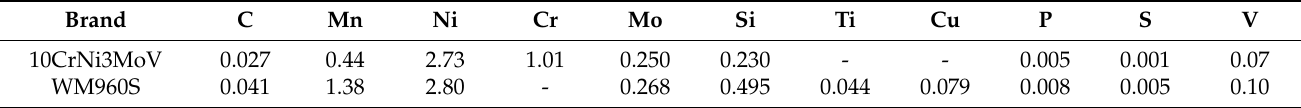
Table 1. Chemical composition of base metal and welding wire (mass fraction, %).